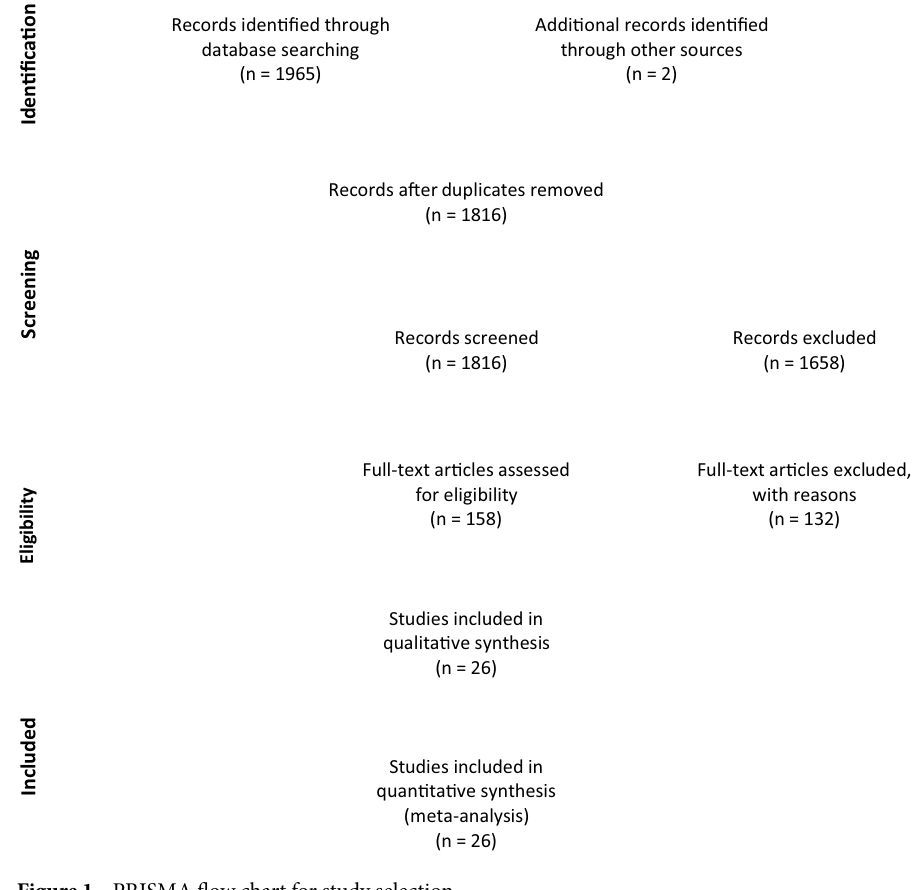
Figure 1. PRISMA flow chart for study